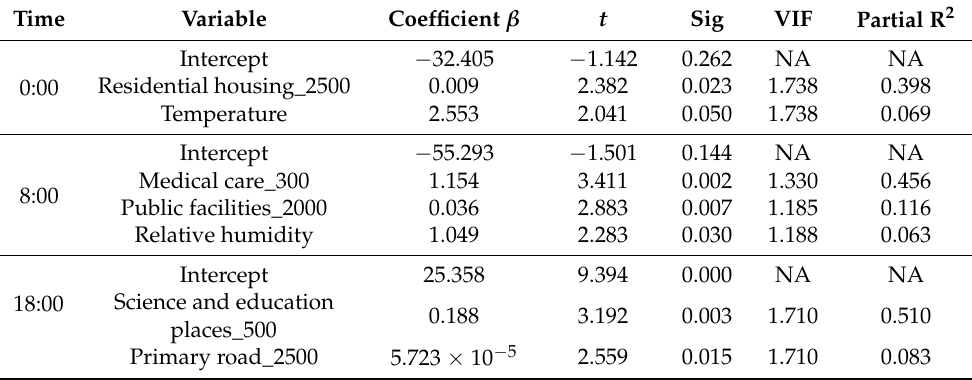
Table 7. LUR models at different times during a summer non-working